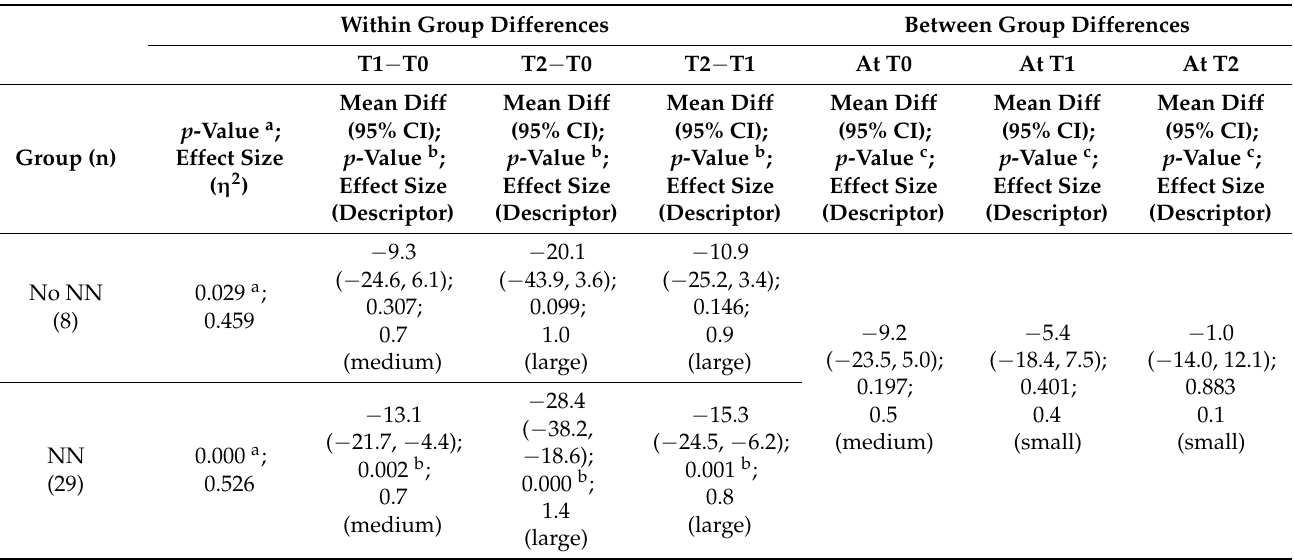
Table 3. Changes in Malaysian psychosocial impact of dental aesthetics questionnaire (PIDAQ) score scores by normative